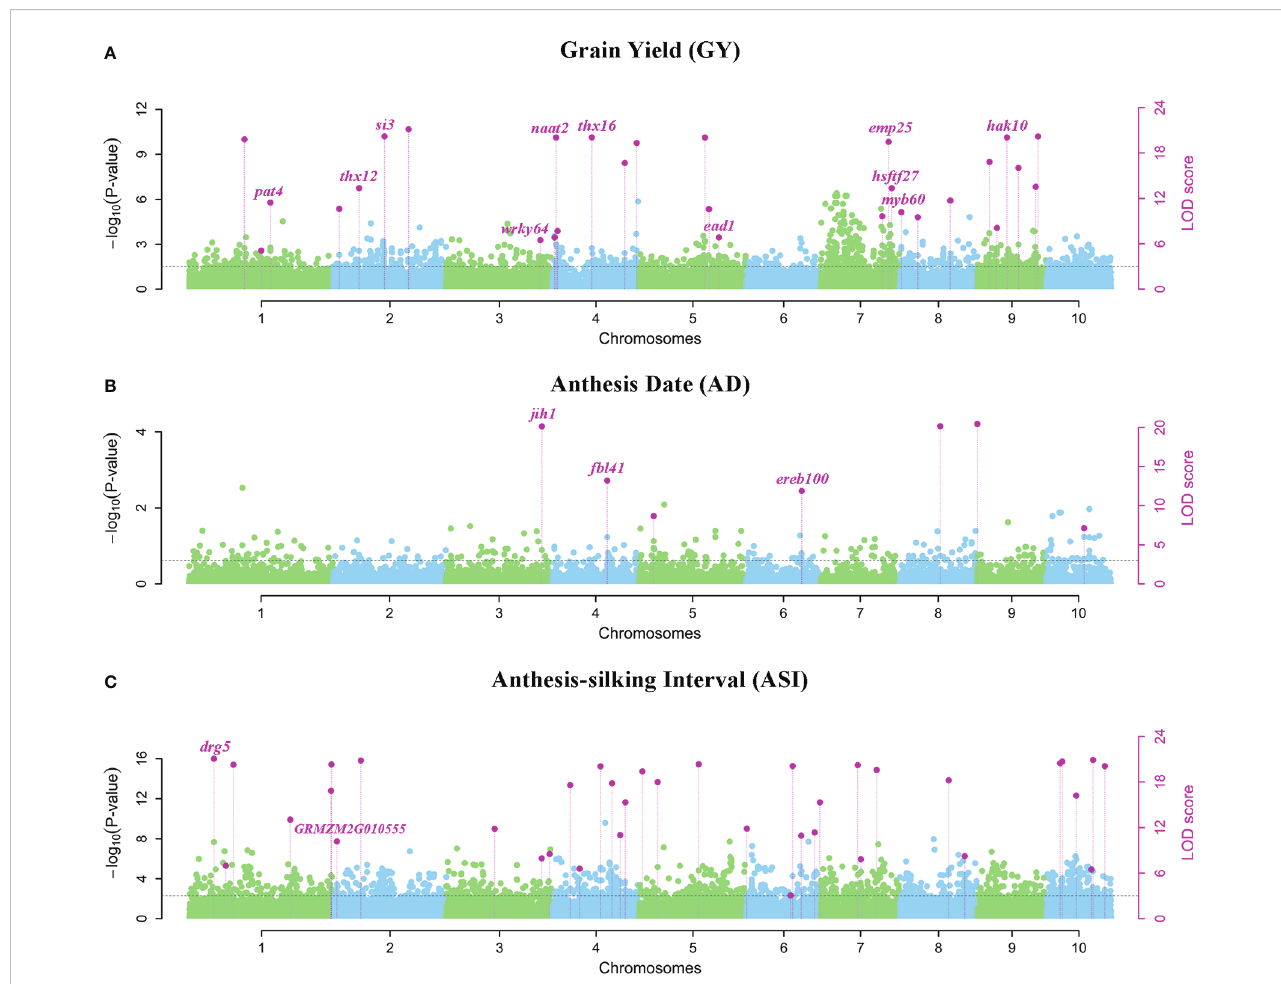
FIGURE 3 Manhattan plots using 3VmrMLM for QEIs on three yield-related traits (A) GY, (B) AD, and (C) ASI under four environments. Y-axis on the left side represents -log10 (P-values) of QEIs, which are obtained from single-marker genome-wide scanning for all markers, while y-axis on the right-side represents LOD scores, which are obtained from likelihood ratio test for QEIs, with the threshold of LOD = 3.0 (dashed line). These LOD scores are shown in points with straight lines. Highlighted text is the corresponding known gene of the